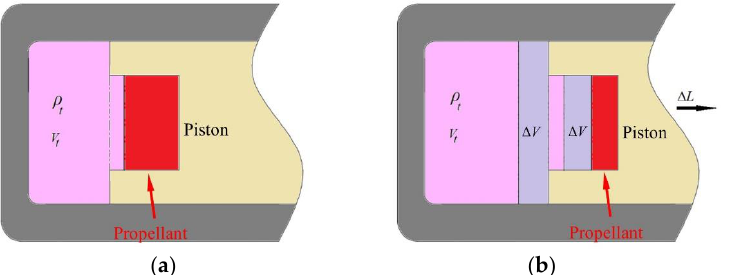
Figure 4. The interior ballistic model of piston movement: ( a ) at a certain time t, ( b ) after an increment time Δ t .